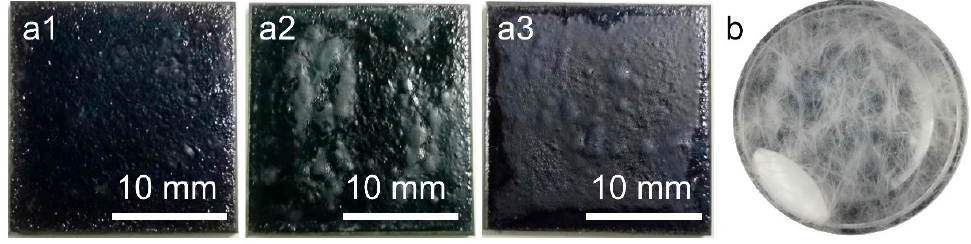
Figure 1. Effect of different amounts of PA on the rust conversion performance of GA: ( a1 ) 2% PA, ( a2 ) 3% PA, ( a3 ) 5% PA, ( b ) flocculent precipitation.